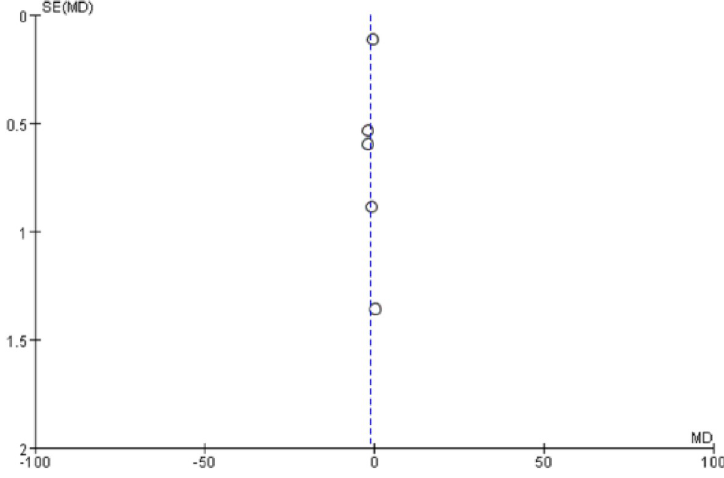
Fig 5. Funnel plots showing publication bias among studies used to compare IFMs training and control